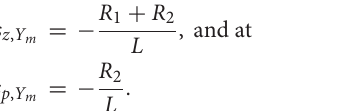
two resistances in the small-signal equivalent circuit model of Figure 8B ,